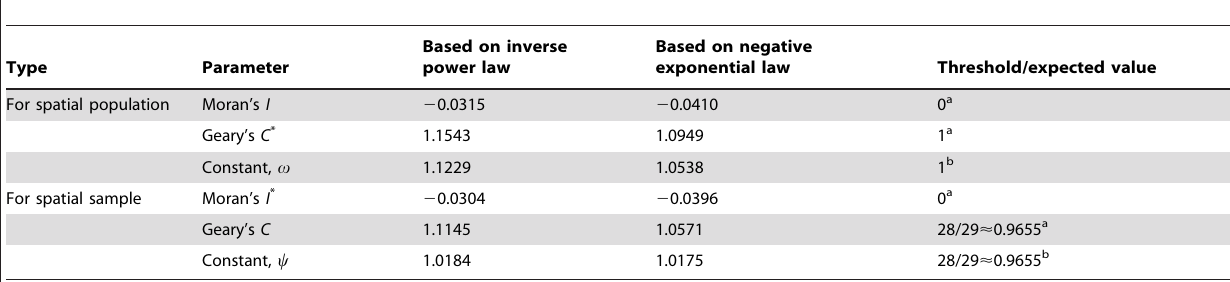
Table 4. Moran’s index and Geary’s coefficient values based on spatial population and sample of Chinese cities (2000).